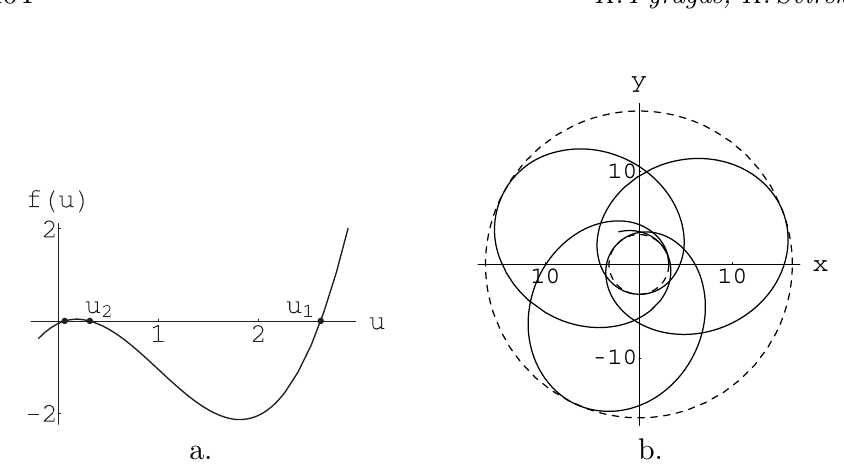
Fig. 3. (a) The roots of the cubic f ( u ) and (b) corresponding trajectory for 1 /u 3 < r < 1 /u 2 . The graphs are given for δ = 1, σ = 4, γ = 1, h = − 0 .